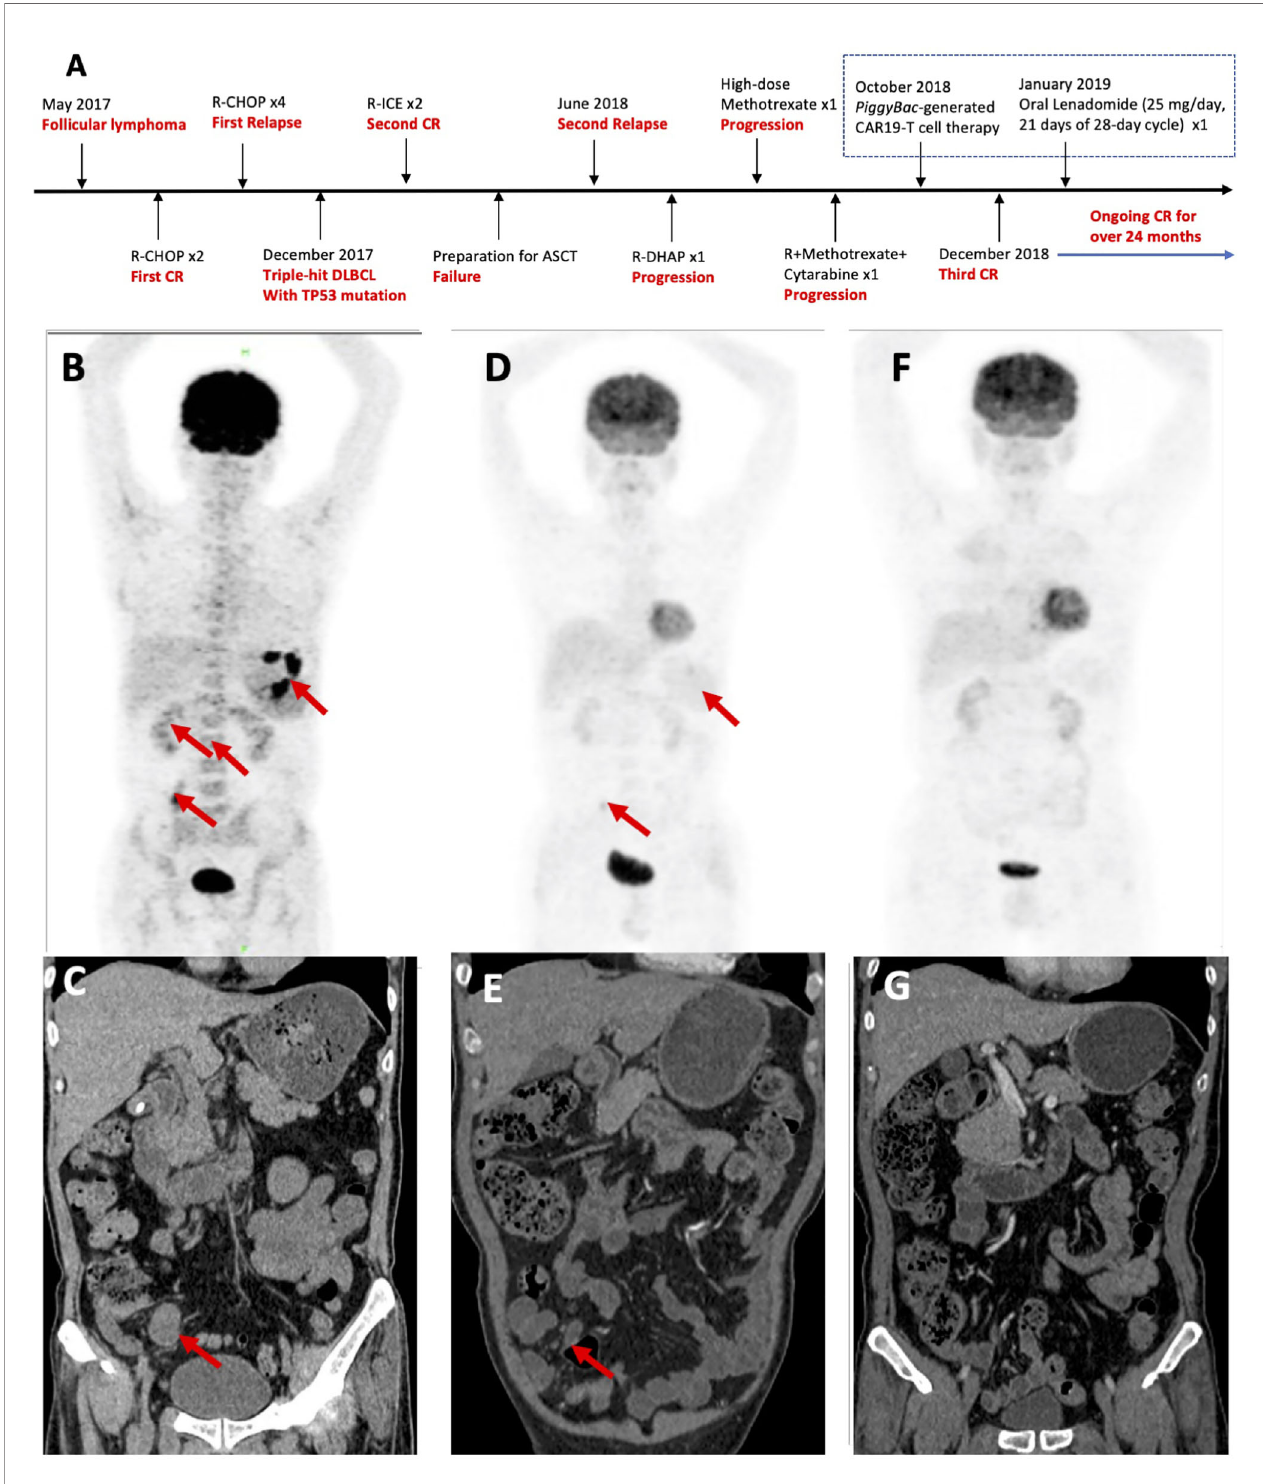
FIGURE 1 | Patient treatment history and response to piggyBac -generated CAR19-T cells. (A) Patient ’ s disease progression and lymphoma treatment history. (B) Pre-treatment PET-CT, showing extensive invasion of tumors in gastric wall (SUVmax 13.2 – 18.0), small intestines (SUVmax 6.7) and bone marrow (SUVmax 2.6 – 3.2), scoring 5 points per Deauville criteria. (C) Pre-treatment abdominal CT, showing an abnormal mass sized as 3.0 × 2.2 cm (arrow). (D) PET-CT in the 1st month post-infusion, showing diminished invasion of tumors in small intestines (SUVmax 4.6) scoring 3 points per Deauville criteria. (E) Abdominal CT scans in the 1st month, showing an abnormal mass sized as 1.6 × 1.0 cm (arrow). (F) PET-CT scans were consistent with a complete metabolic response in the 2nd month post- infusion. (G) Normal Abdominal CT in the 2nd